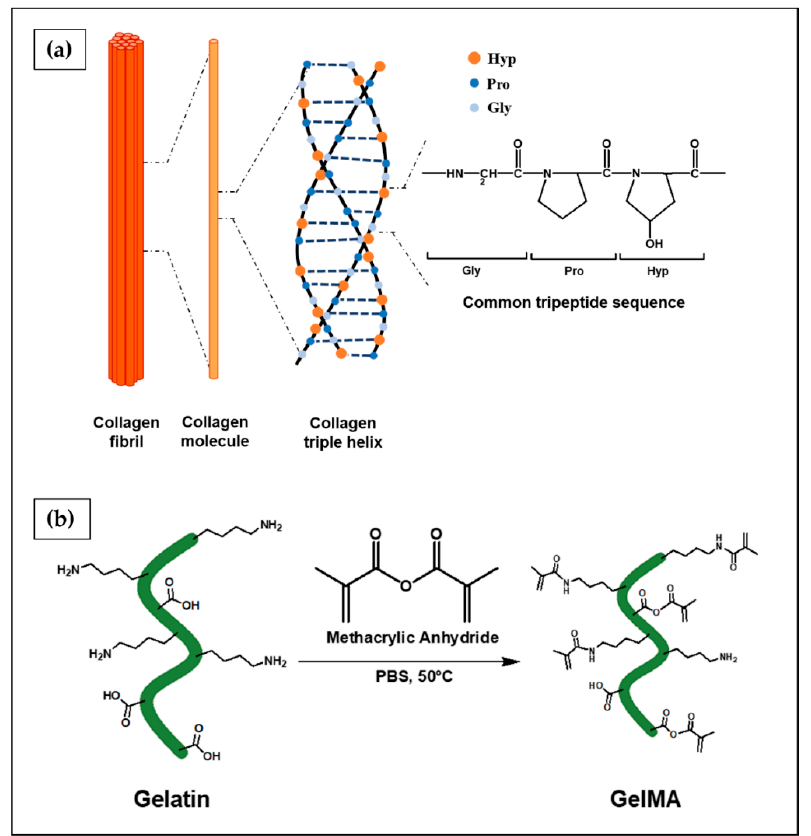
Figure 11. Chemical structure of proteins investigated for hydrogel-based scaffolds in OC modeling. ( a ) Triple chain structure of collagen fibrils and chemical structure of the most common tripeptide sequence found in collagen, composed of Gly, Pro and Hyp sequences, ( b ) gelatin and its reaction with methacrylic anhydride to form photocrosslinkable gelatin–methacryloyl